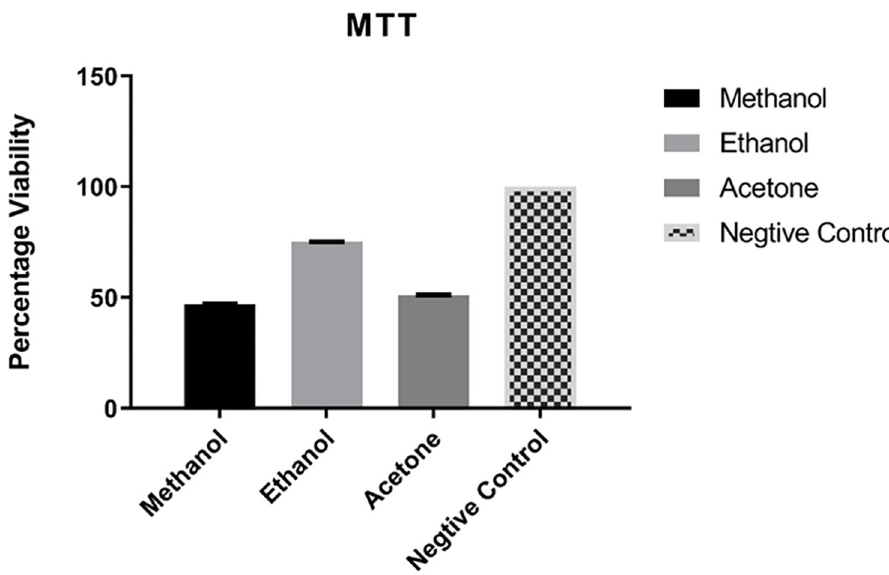
Fig 5. Anti-proliferative activity of leaf of Artemisia absinthium . Viable cell (percentage) response of Huh7 liver cancer cell line to three different kinds of organic solvents i.e., Methanol, Ethanol, Acetone. Bar represents ± SEM. Data was analyzed by one-way analysis of variance (ANOVA) (P < 0.001). * = significant, ns = non-significant.